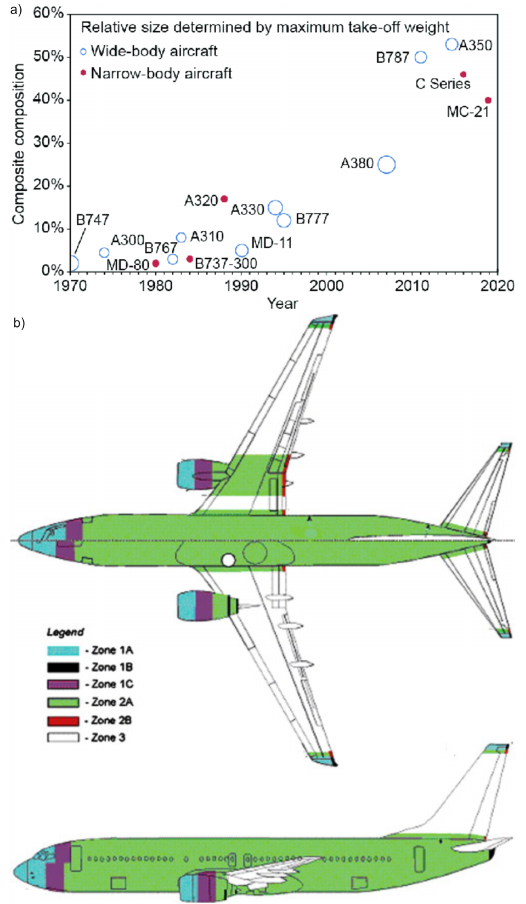
Figure 1. ( a ) Amount of composite material used in commercial aircraft since 1970 [3]; ( b ) lightning strike zones of a commercial aircraft according to SAE ARP 5414. (Reprinted from Feraboli et al. (2009) [7] under permission from